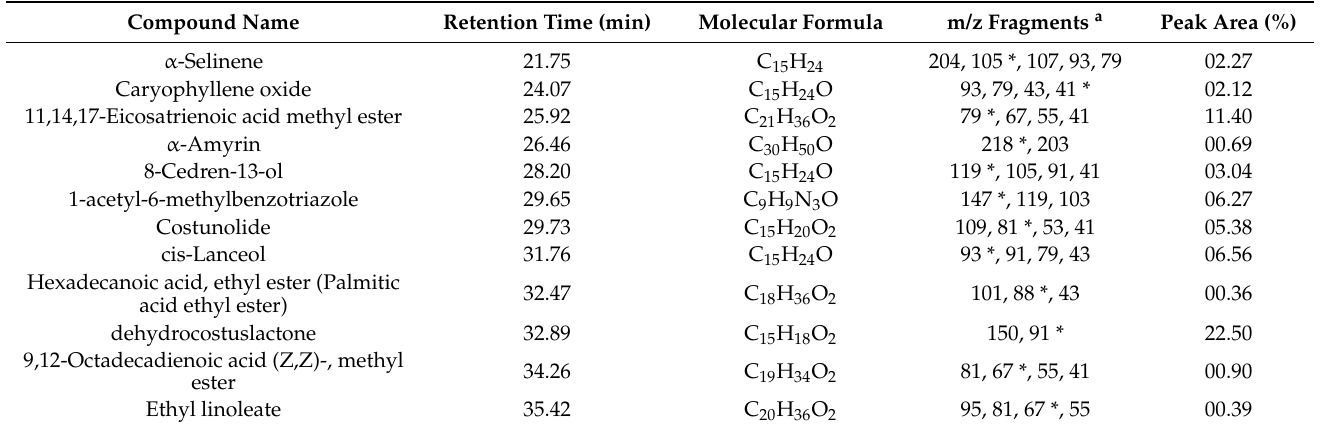
Table 3. Volatiles composition of n -hexane extract of Saussurea costus roots.